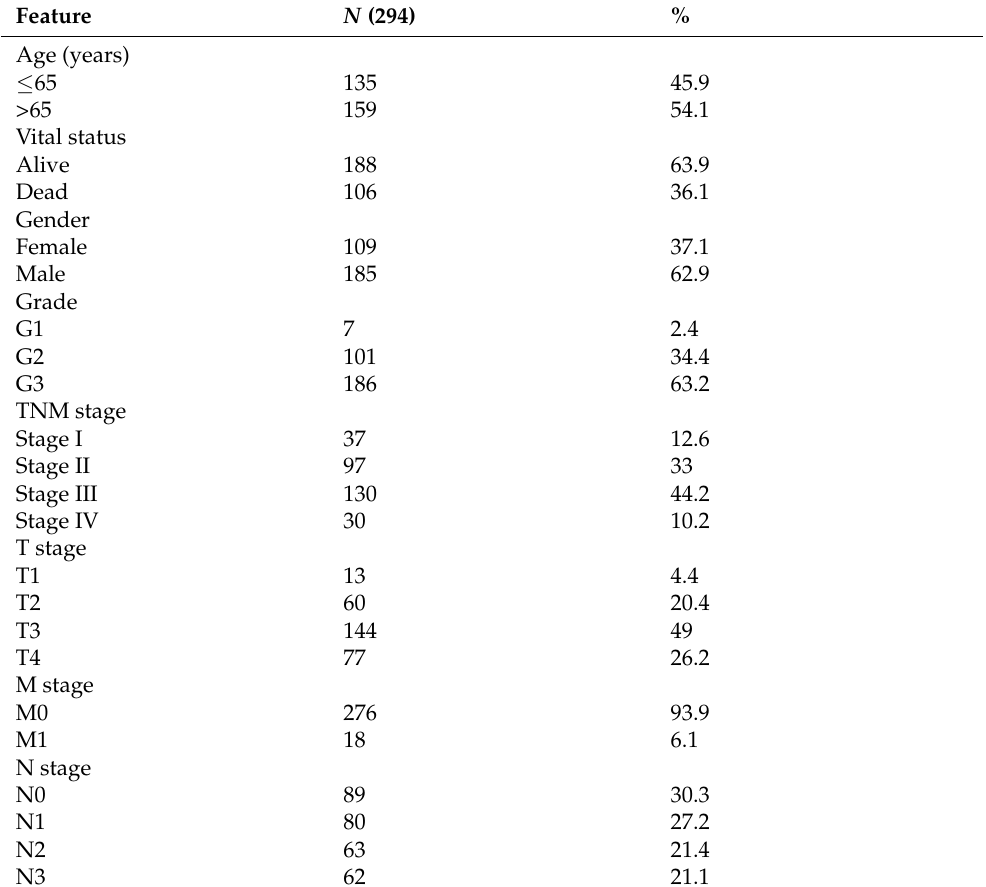
Table 3. Clinical features of stomach adenocarcinoma (STAD) patients in TCGA